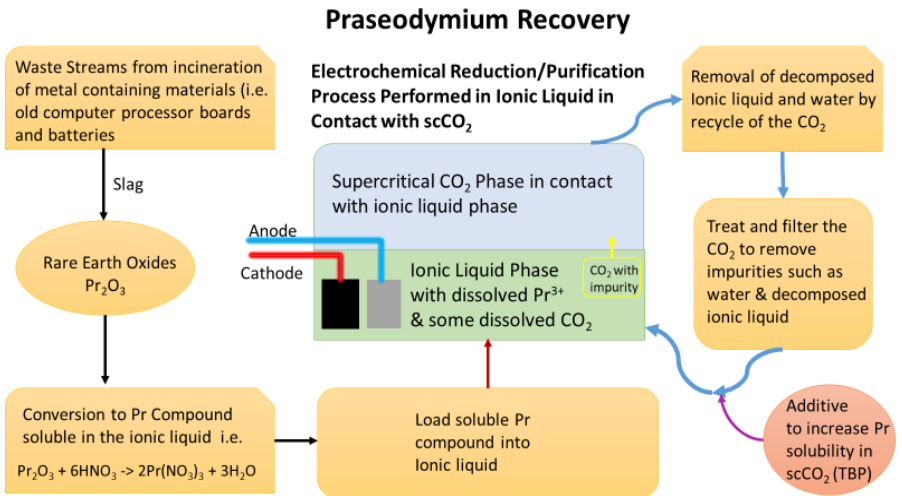
Figure 1. Example of Pr recovery with two-phase impurity removal.